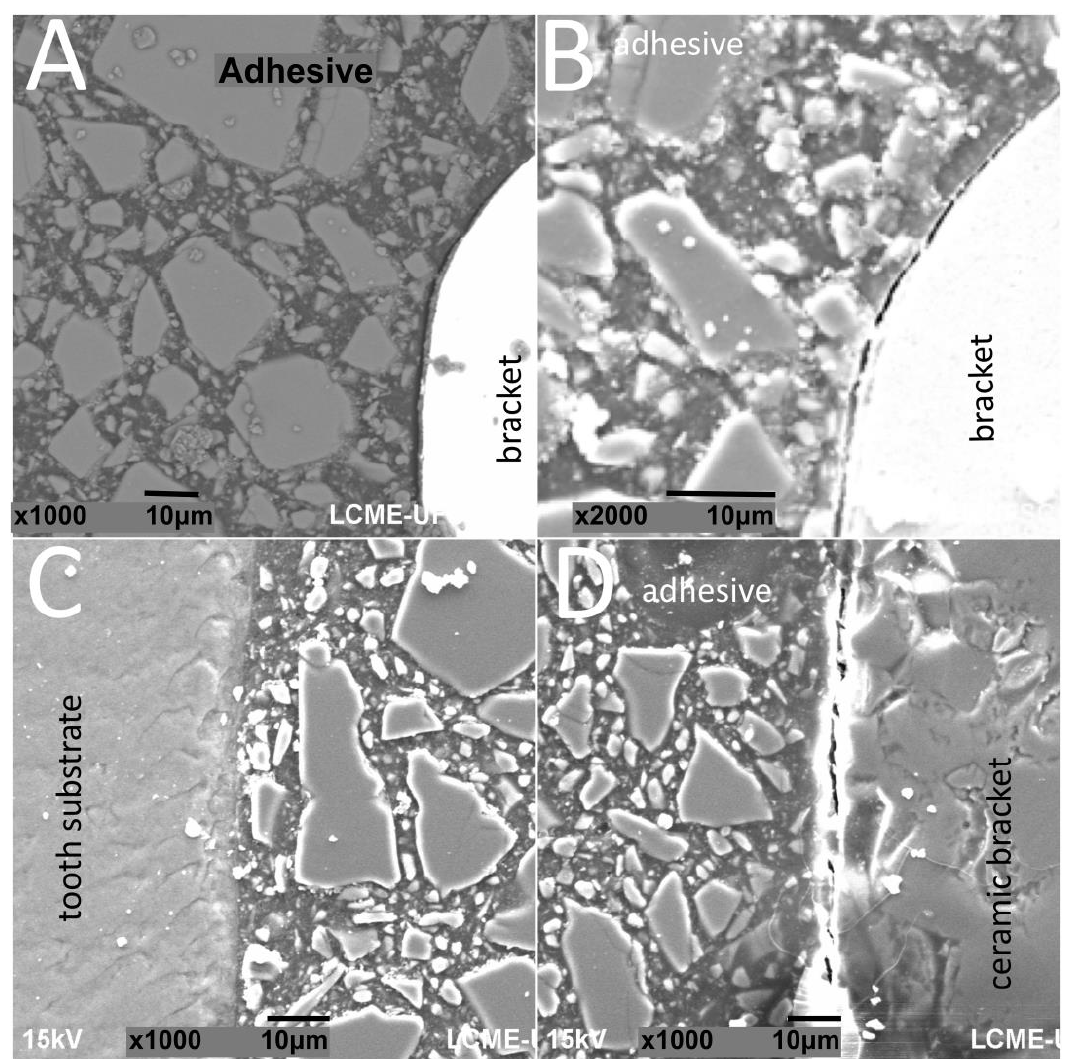
Figure 3. SEM images of cross-sectioned ( A , B ) metallic or ( C , D ) ceramic brackets bonded to enamel surfaces after thermal cycling. Materials 2020 , 13 , x FOR PEER REVIEW